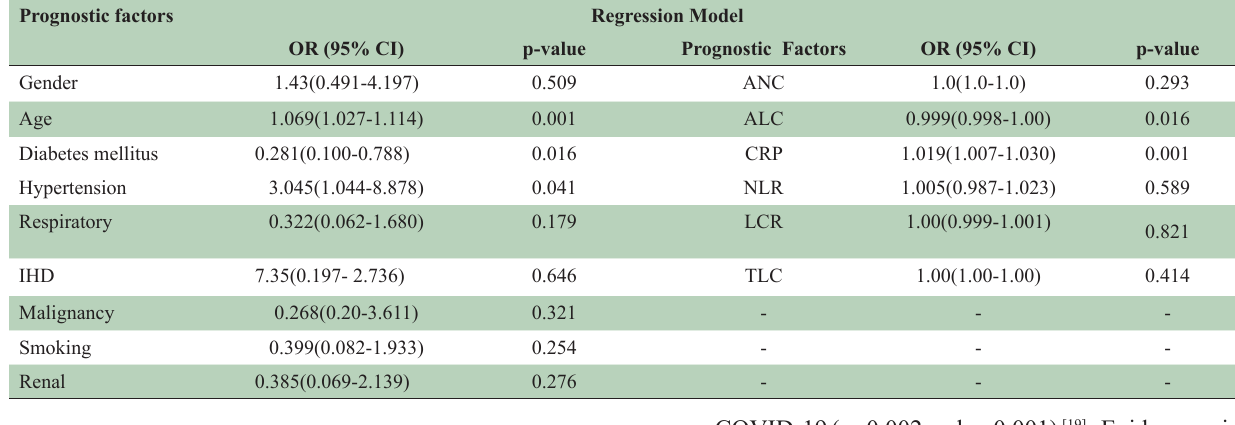
Table-V: Regression model for prognostic factors (Logistic regression